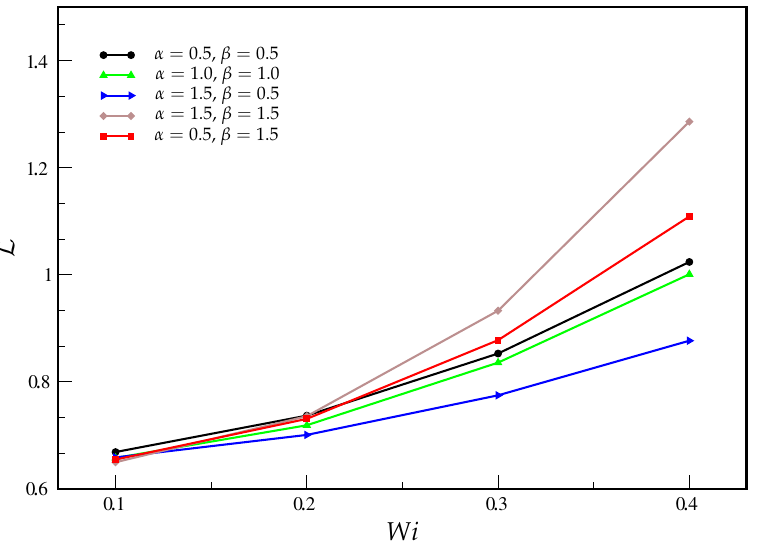
) and mesh M 2 . L 99% ) and mesh M 2 L 99%